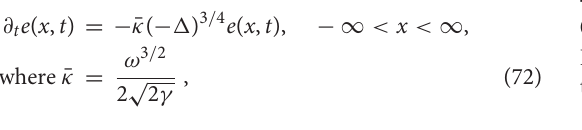
FIGURE 11 | Left and right eigenvectors of matrix L v in Equation (70) for n imaginary part. Note that the eigenvectors corresponding to the real eigenvalues ( n eigenvalues ( n 5,6,7,8 ... ) are complex (adapted from Kundu et al. with permission from [ 34] Copyright (2018) by American Physical =